Question: Give a one-sentence summary of this figure.
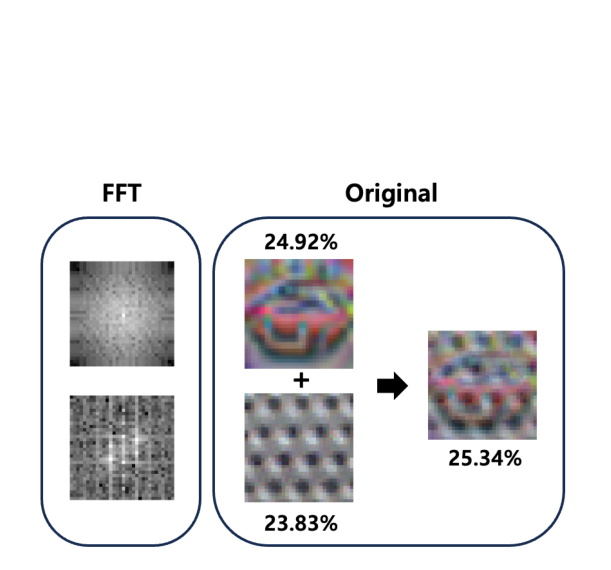
Answer: Results for the average of DSVs (top) and DM (bottom). The Fourier-Transformed images (FFT) indicate that the two lie in different frequency domains and the averaged sample resulted in better accuracy (25.34%).